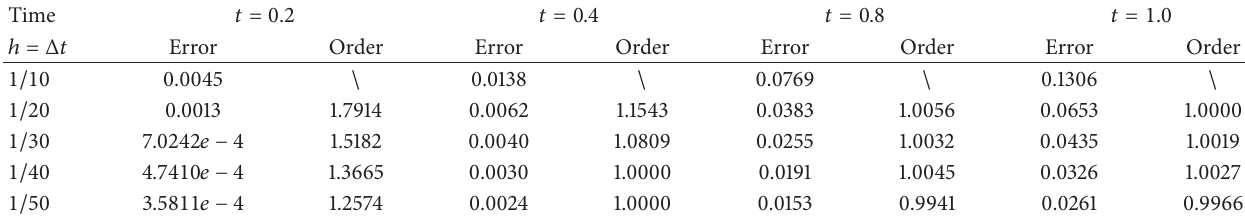
Table 3: The errors of ‖ 𝜎 − 𝜎 ℎ ‖ at different